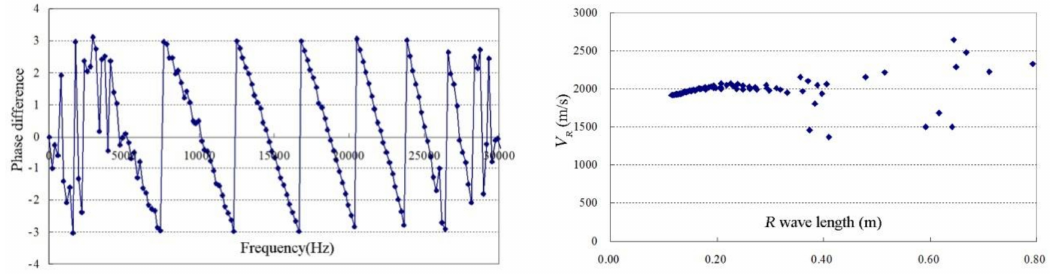
Figure 7. Phase spectrum and dispersion curve of the layered model 1 (concrete-bedrock).